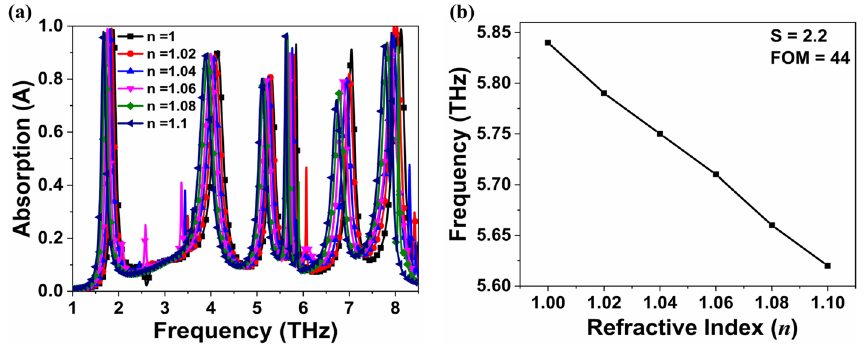
Figure 7. ( a ) Absorption response with different refractive index ( n ) and ( b ) relation between frequency and refractive